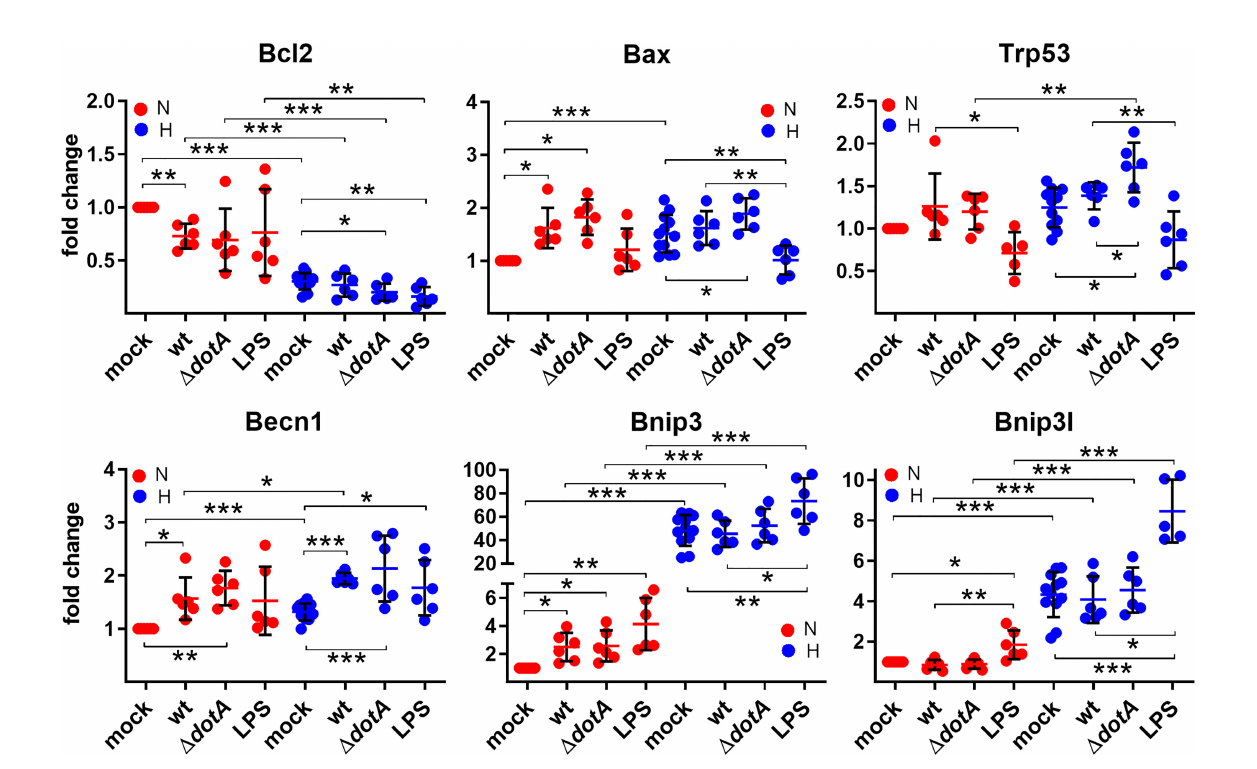
FIGURE 7 | A pro-apoptotic expression signature is more prominent in C. burnetii -infected or hypoxic macrophages. BMDM were either uninfected (mock), infected with C. burnetii (wt), the T4SS transposon mutant ( D dotA ), or treated with LPS (100 ng/ml) for 24 h under normoxia (N) and hypoxia (H). Using qRT-PCR, the gene expression of murine Bcl2 , Bax , Trp53 , Becn1 , Bnip3 , and Bnip3l was analyzed. The data are depicted as Mean ± SD of 2^- DD CT values (using murine HPRT as a calibrator). Fold changes are shown relative to uninfected cells under N. The data shown for each of the C. burnetii (wt and D dotA ) infection experiments and the LPS treatment experiment represent 3 independent experiments with biological duplicates. One sample t test or t test, n=5-6. ***p < 0.001, **p < 0.01, *p <